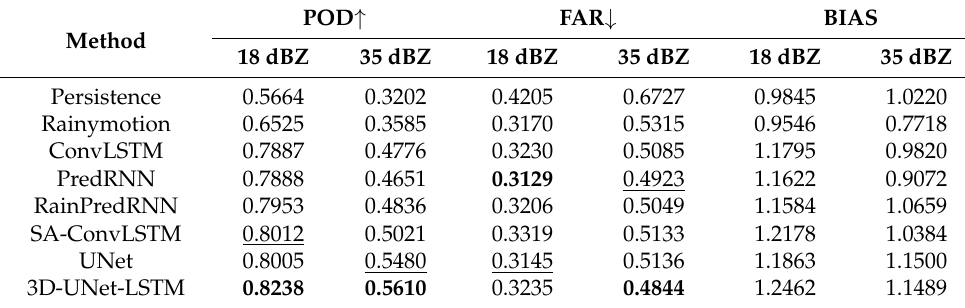
Table 3. Evaluation scores of our proposed model with